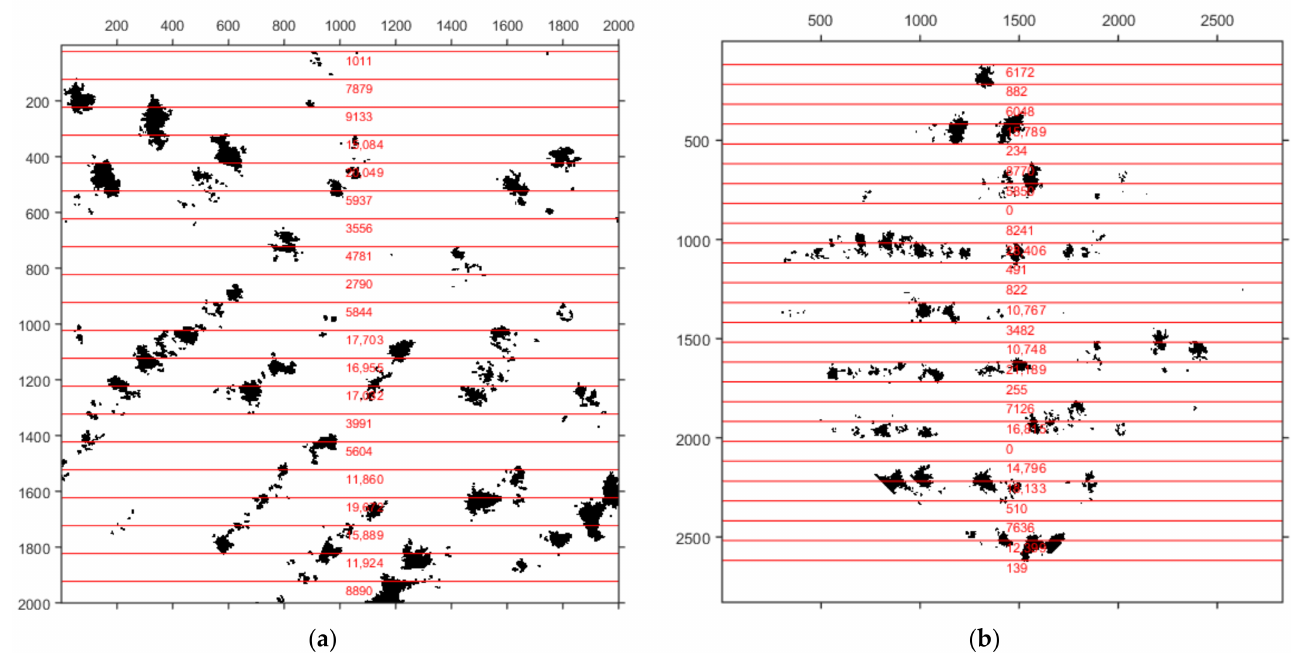
Figure 4. The diagram of the grid-variance (GV) method: ( a ) distribution of canopy pixels in grids before rotation; ( b ) distribution of canopy pixels in grids after rotation. Note: the figure in red is the number of canopy pixels in each grid.